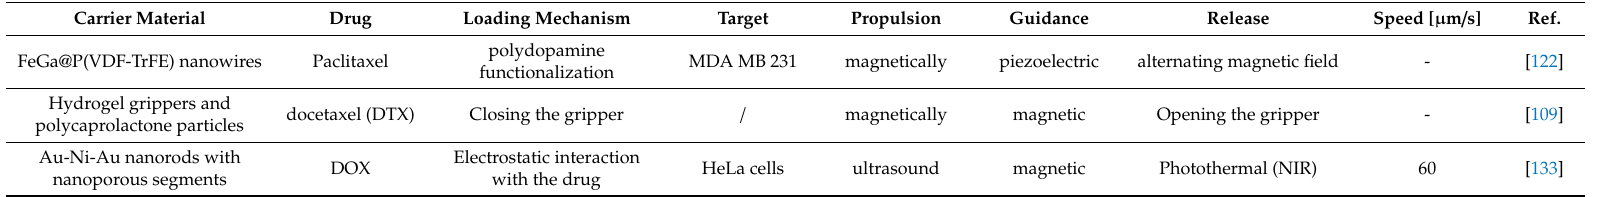
Table 2. List of field driven nano- and micromotors for drug